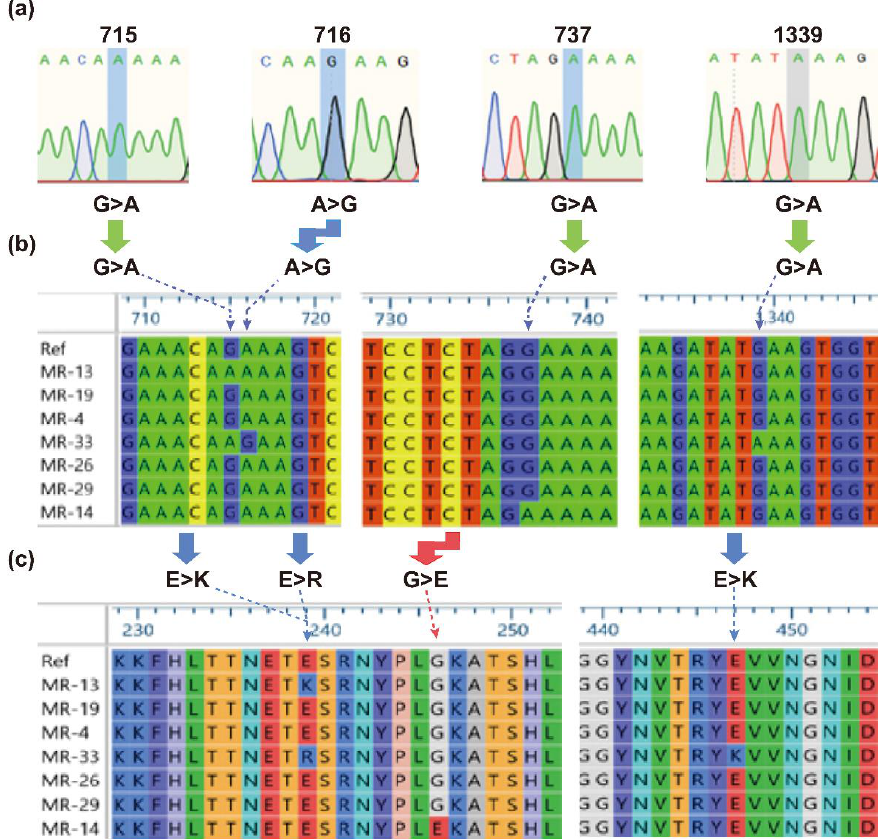
Figure 1. The detected variations in the mecA gene in the MRSA isolates (MR-13, -19, -4, -33, -26, -29, and -14). ( a ) Chromatograms showing nucleotide substitutions at different locations. ( b ) Multiple DNA sequence alignment. ( c ) Multiple protein sequence alignment. The sign “>” represents a substitution mutation. The left “E>K”, “E>R”, “G>E”, and the right “E>K” refer to E239K, E239R, G246E, and E447K, as shown by the dashed arrows. The left “G>A”, “A>G”, and “G>A”, and the right “G>A” refer to G715A, A716G, G737A, and G1339A. “Ref” represents the reference sequence (GenBank accession no. NC_002745). The MRSA isolates (MR-13, -14, and -33) show amino acid substitution(s) in PBP2a.